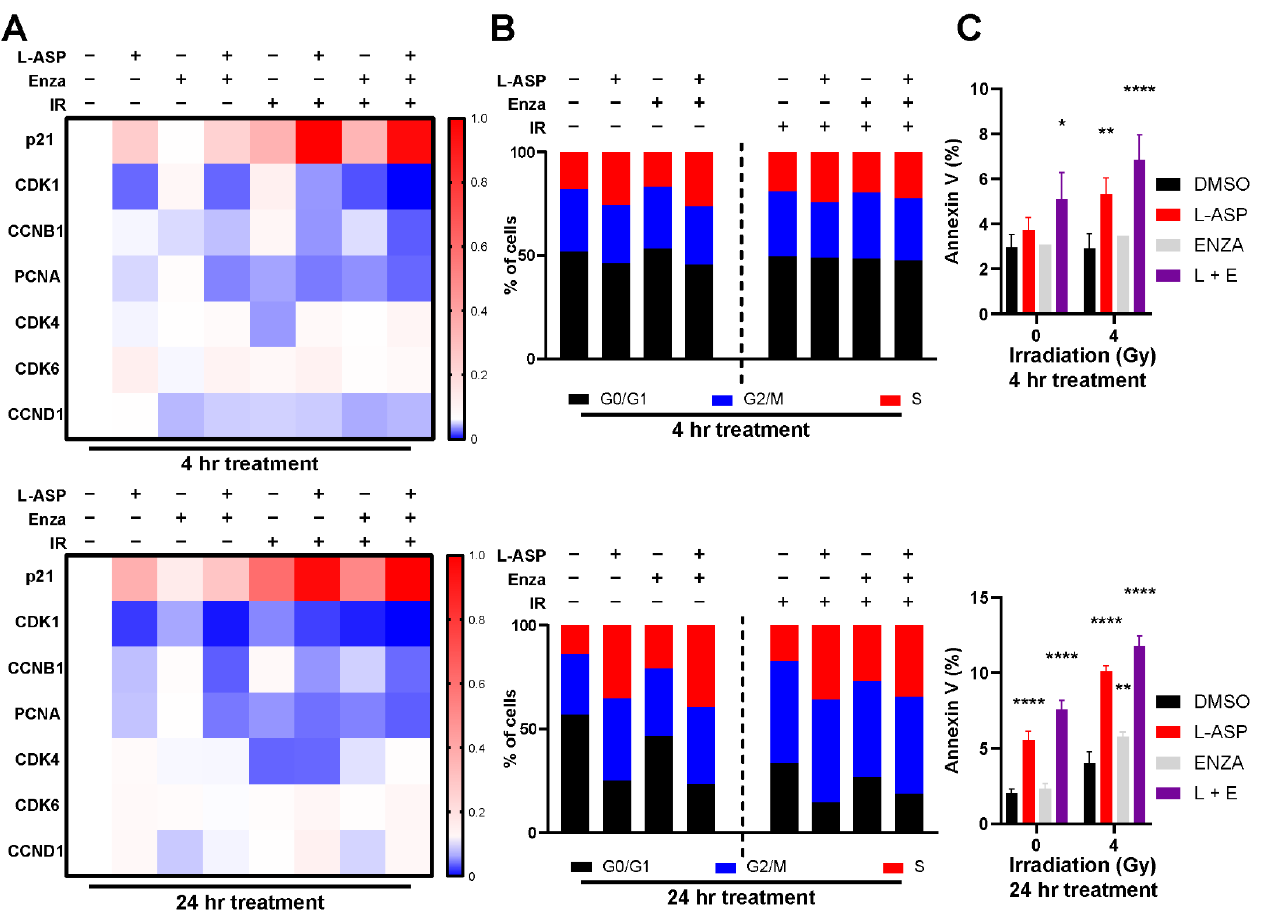
Figure 3. Glutamine depletion leads to cell cycle arrest and cell death. 22RV1 cells were pre-treated with L-ASP (2 IU/mL), enzalutamide (10 µM), or both for 24 h. Cells were harvested 4 or 24 h after the indicated doses of irradiation (IRR). ( A ) The mRNA expression of G1/S (CDK4, CDK6, and CCDN1) and G2/M checkpoint markers (p21, CDK1, CCNB1, and PCNA) was determined by RT-PCR. mRNA expression was normalized to ß-actin and untreated samples. ( B ) Propidium iodide-stained cells were subjected to cell cycle analysis by FACS 4 and 24 h after irradiation. ( C ) Apoptotic status of cells 4 and 24 h after irradiation was determined by FACS analysis of cell surface annexin V. All studies are reported as a mean of at least three independent experiments (* p < 0.05, ** p < 0.01, **** p < 0.0001).